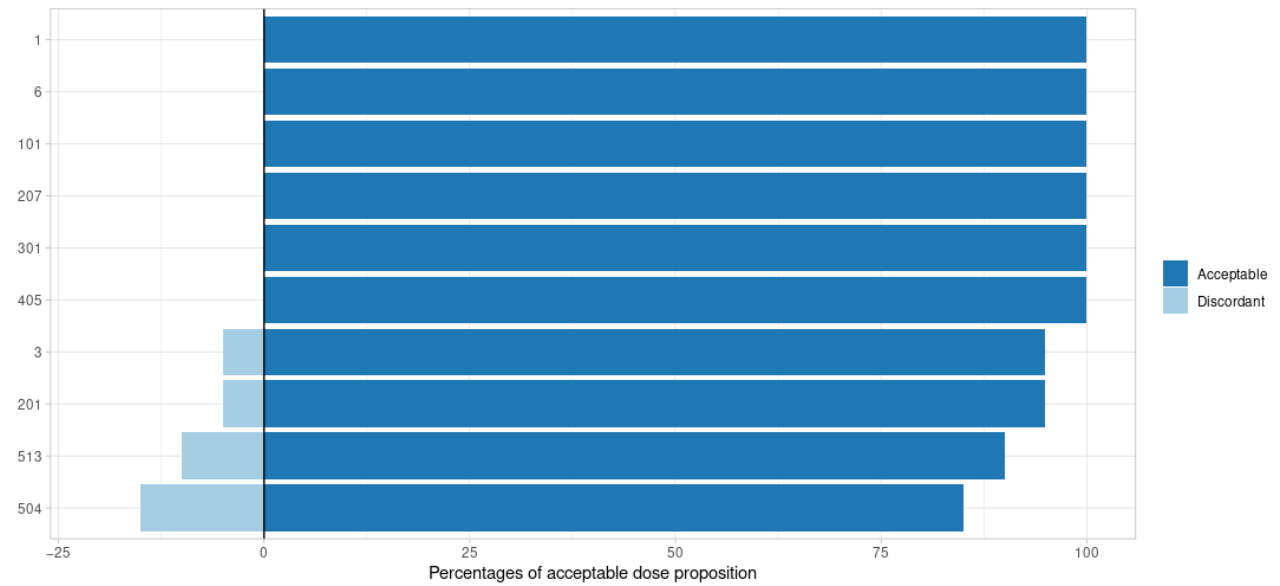
Figure 3. Adequacy of dose adaptation by tested model for a target concentration based on SIR posterior estimates. The negative percentages are the proportions of discordant propositions.